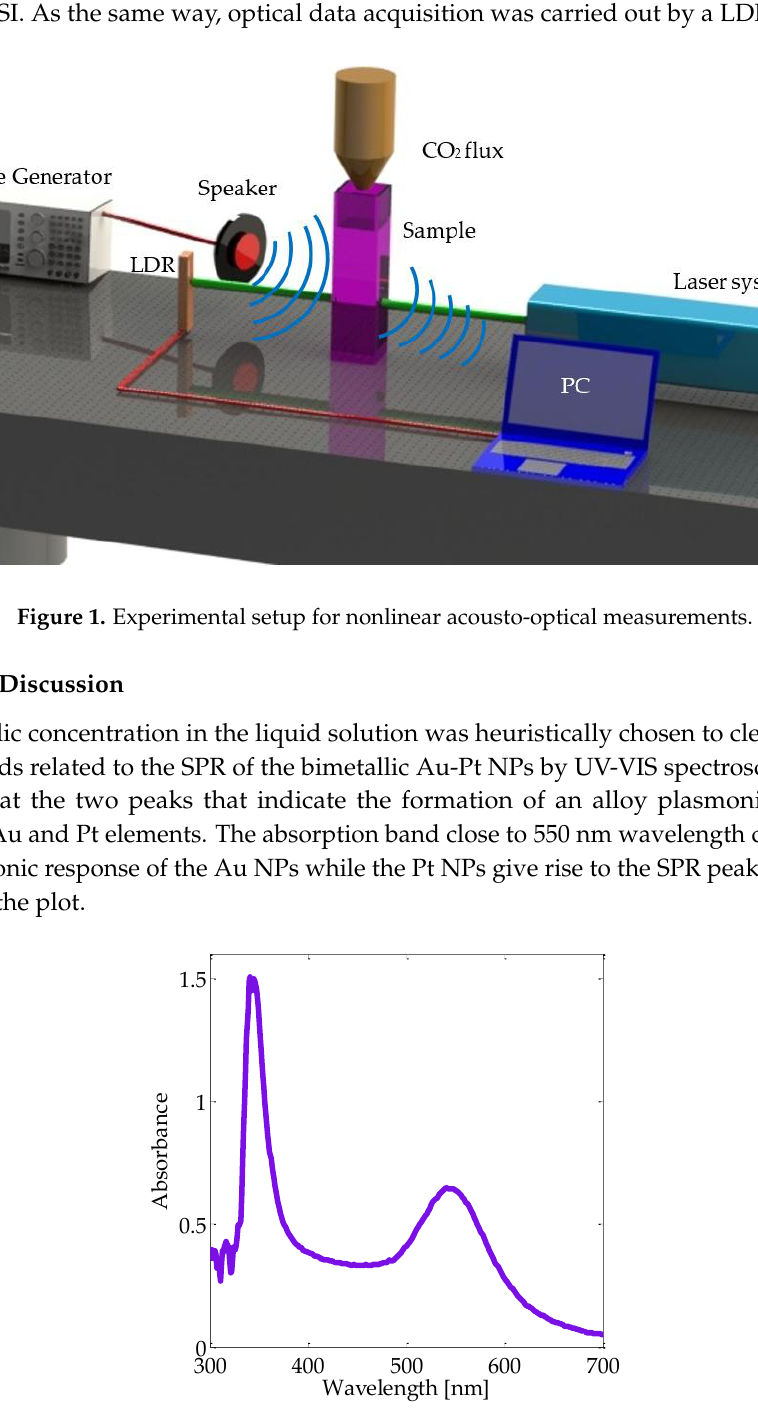
Figure 2. Optical absorption spectrum of Au-Pt NPs suspended in an ethanol solution.